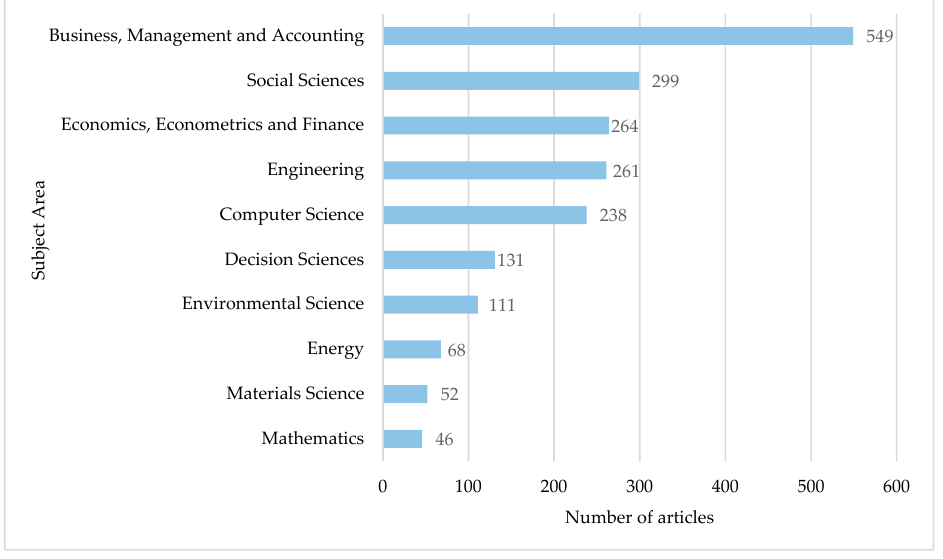
Figure 3. Top 10 subject areas (1961–2019).